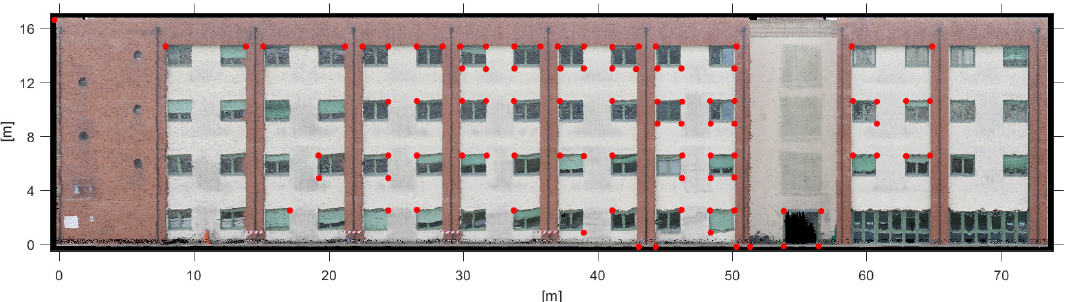
Figure 6. Photogrammetric reconstruction of the building façade (front view). Positions of the 90 check points used to estimate reconstruction accuracy (red circles).